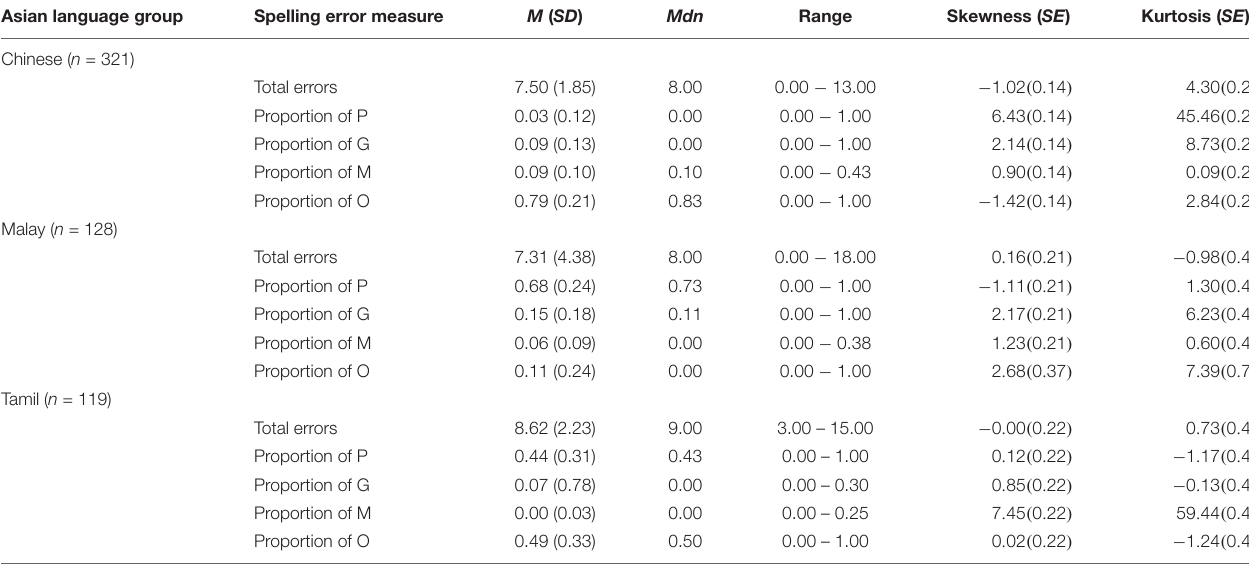
TABLE 5a | Average overall errors and proportions of error types for Asian language groups in the full sample ( N = 568). Asian language group Spelling error measure M ( SD ) Mdn Range Skewness ( SE ) Kurtosis ( SE ) Chinese ( n = 321)